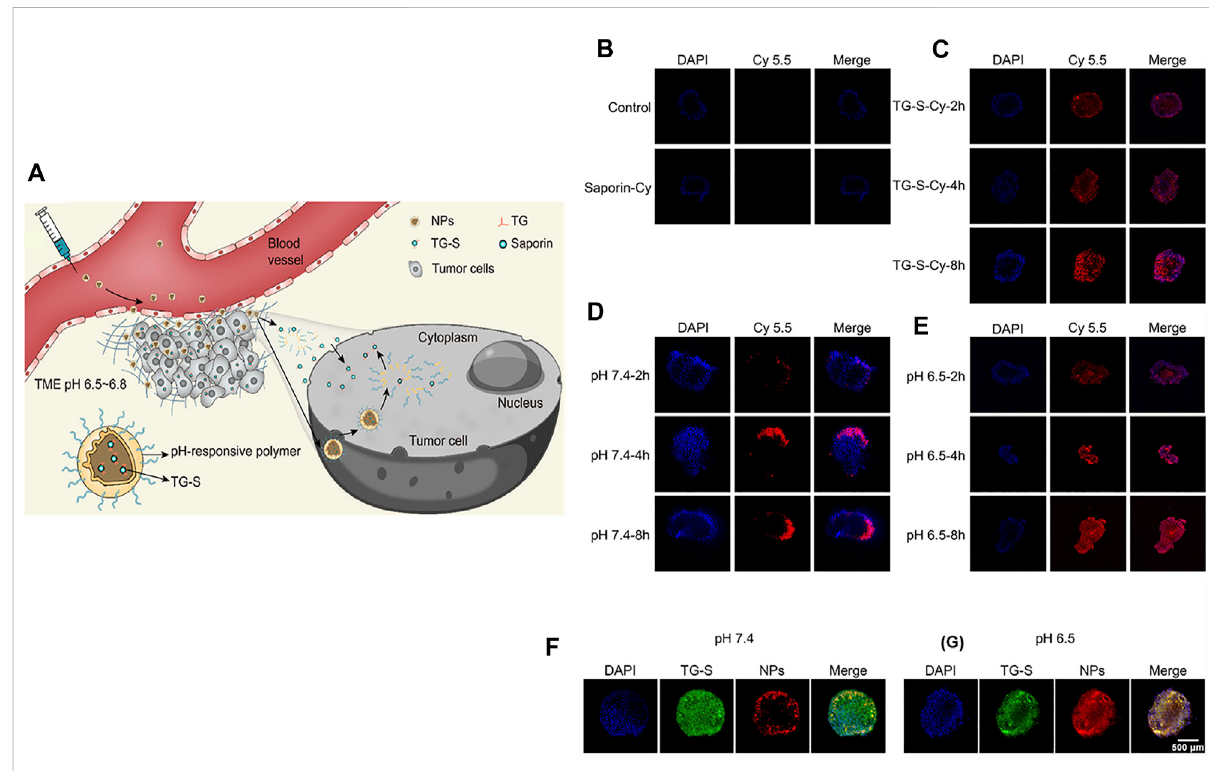
FIGURE 3 (A) Schematic illustration of the formulation of the NPs, release of TG-S in the TME, penetration of tumor tissue, and cellular uptake. (B – E) Fluorescent images of A549 tumor spheroids incubated with saporin (B) , TG-S (C) , and TG-S NPs at pH 7.4 (D) or 6.5 (E) for 2, 4, or 8 h, as measured byCLSM.ThesaporinproteinwasconjugatedtoCy5.5for fl uorescenceimaging. (F,G) FluorescenceimagesofA549tumorspheroidsincubatedwith FAM-labeled TG-S (green) and Cy5.5-labeled TG-S NPs (red) at pH 7.4 (F) or 6.5 (G) for 2 h, as measured by CLSM. Scale bar, 500 μ m. Reproduced with permission (Fu et al., 2022). Copyright 2022, American Chemical